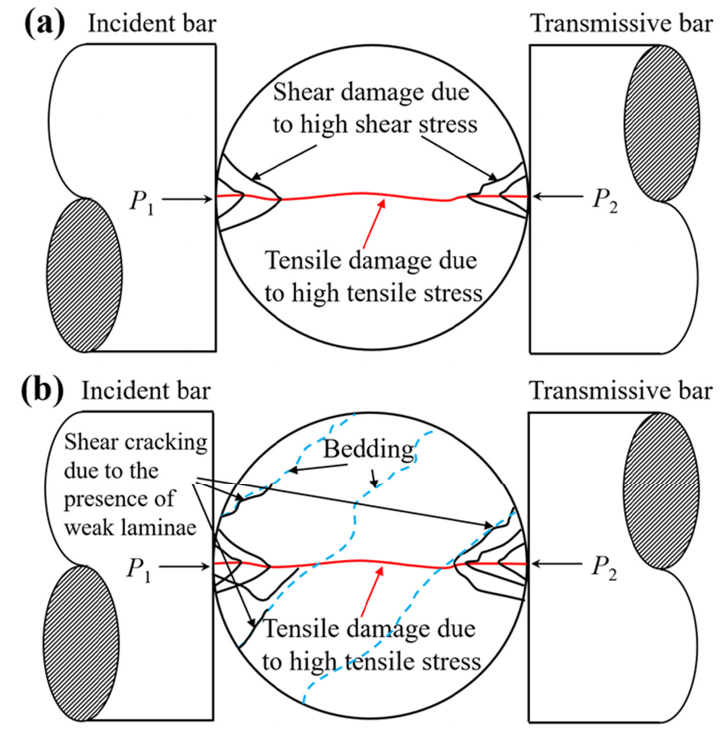
Figure 15. Comparison of loading and failure modes of layered rock. ( a ) Homogeneous and isotropic rocks. ( b ) Non-homogeneous and anisotropic coal rocks.